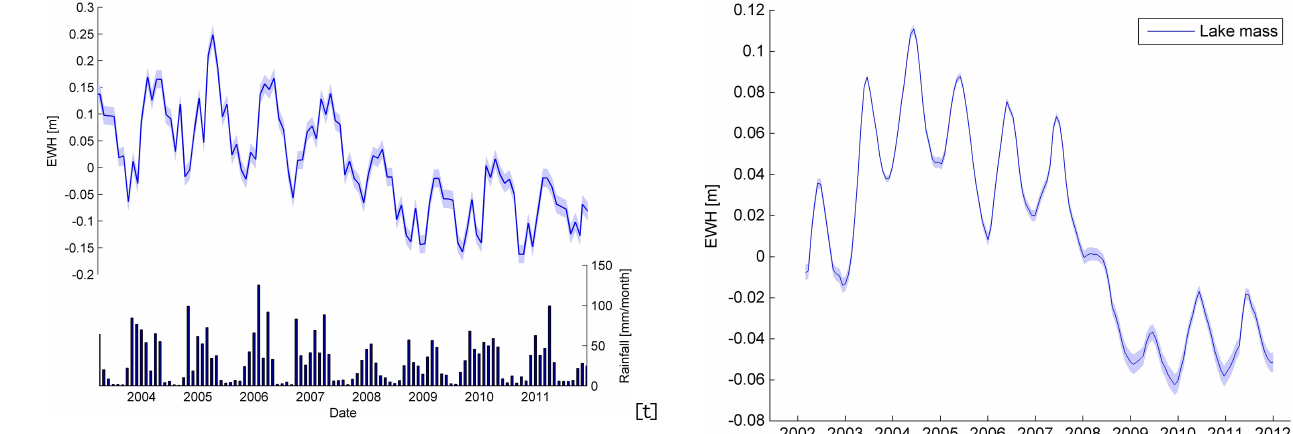
Figure 7. GRACE values and monthly precipitation for extended study area. During the wet winter periods, water accumulates in the region and total water mass increases. Largest water mass depletion occurred during seasons of 2007/2008 and 2008/2009.